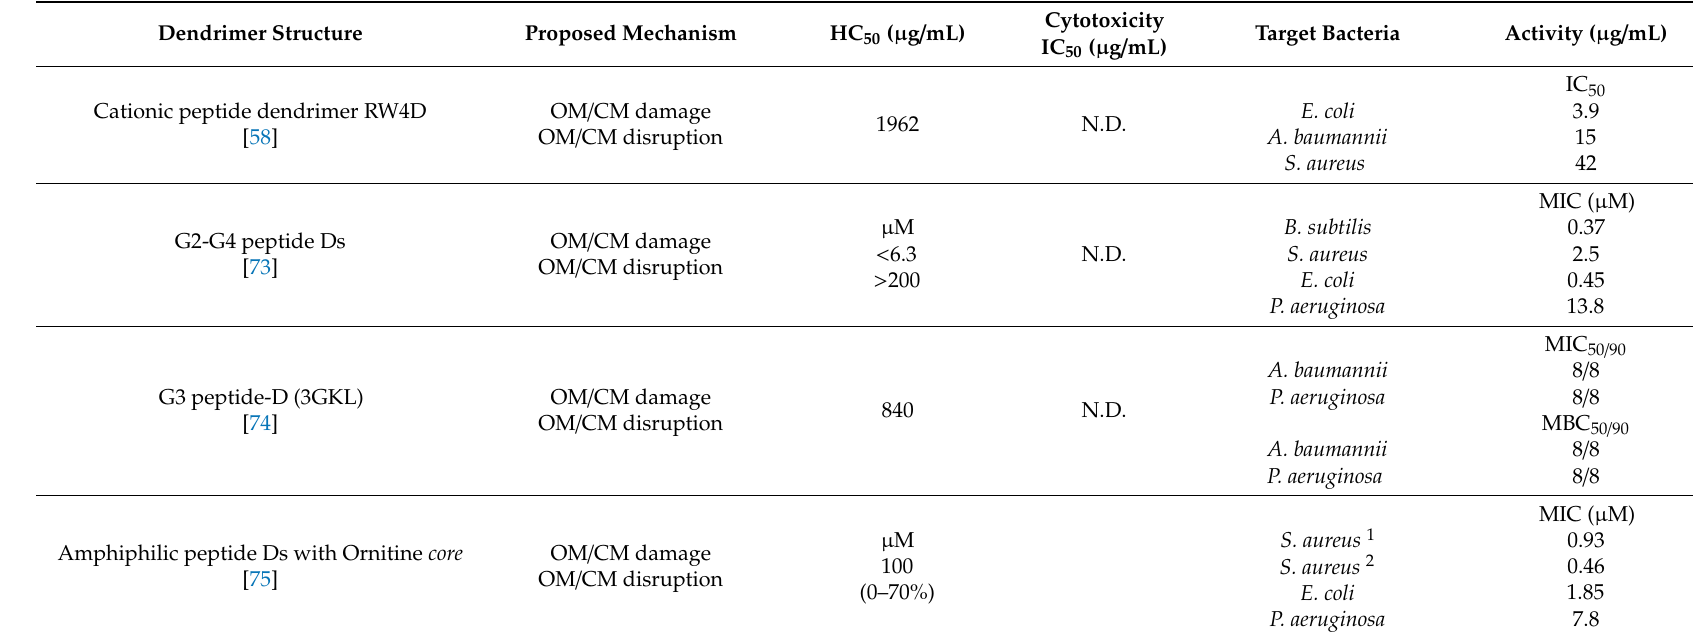
Table 7. Most representative cationic antibacterial peptide Ds developed in the years 2010–2020 and antibacterial activity of the most e ff ective ones among synthetized